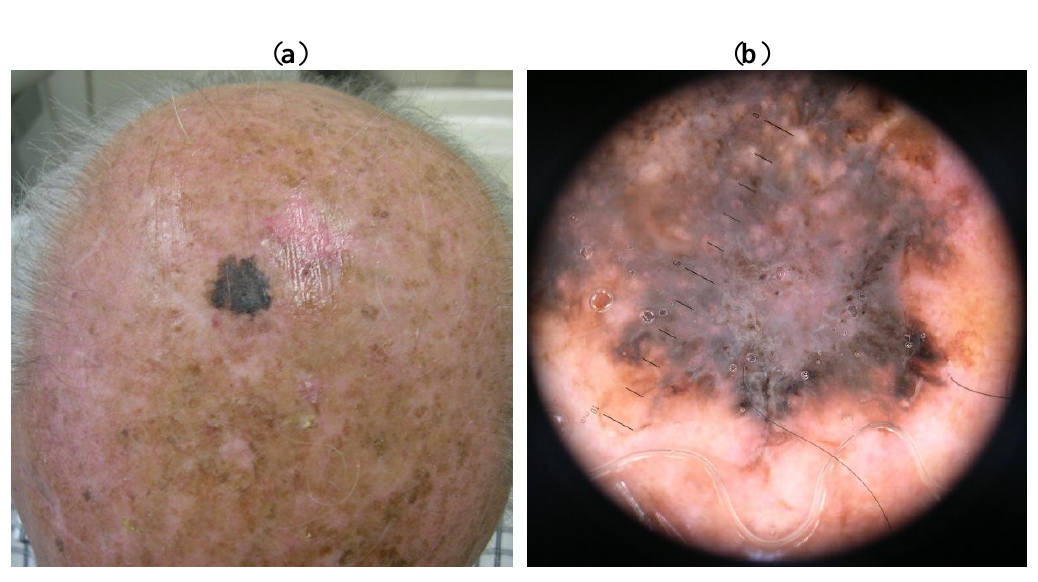
Figure 3. Case 3. ( a ). Naked eye aspect: a 13mm black patch, with irregular borders; ( b ). Dermatoscopic aspect: a black rhomboidal structure, peripheric dots, irregular streaks and a central white-blue